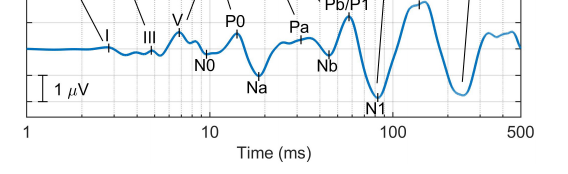
FIGURE3 Example of the full-range auditory evoked response, which provides a comprehensive representation of all the components of the auditory pathway—from the cochlea to the cortex (de la Torre et al.,